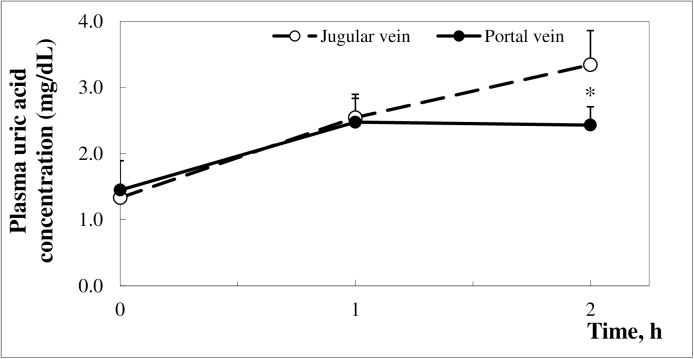
Uric acid concentration in jugular and portal vein blood plasma in healthy pigs i.v. infused with a uric acid suspension (5 mg/kg b.w. each 30 min.), beginning after baseline blood sampling.Data are presented as means ± SD (n = 6). Asterix (*) describes a significant difference between uric acid concentrations in portal and jugular vein blood at last point of blood sampling, p < 0.05.